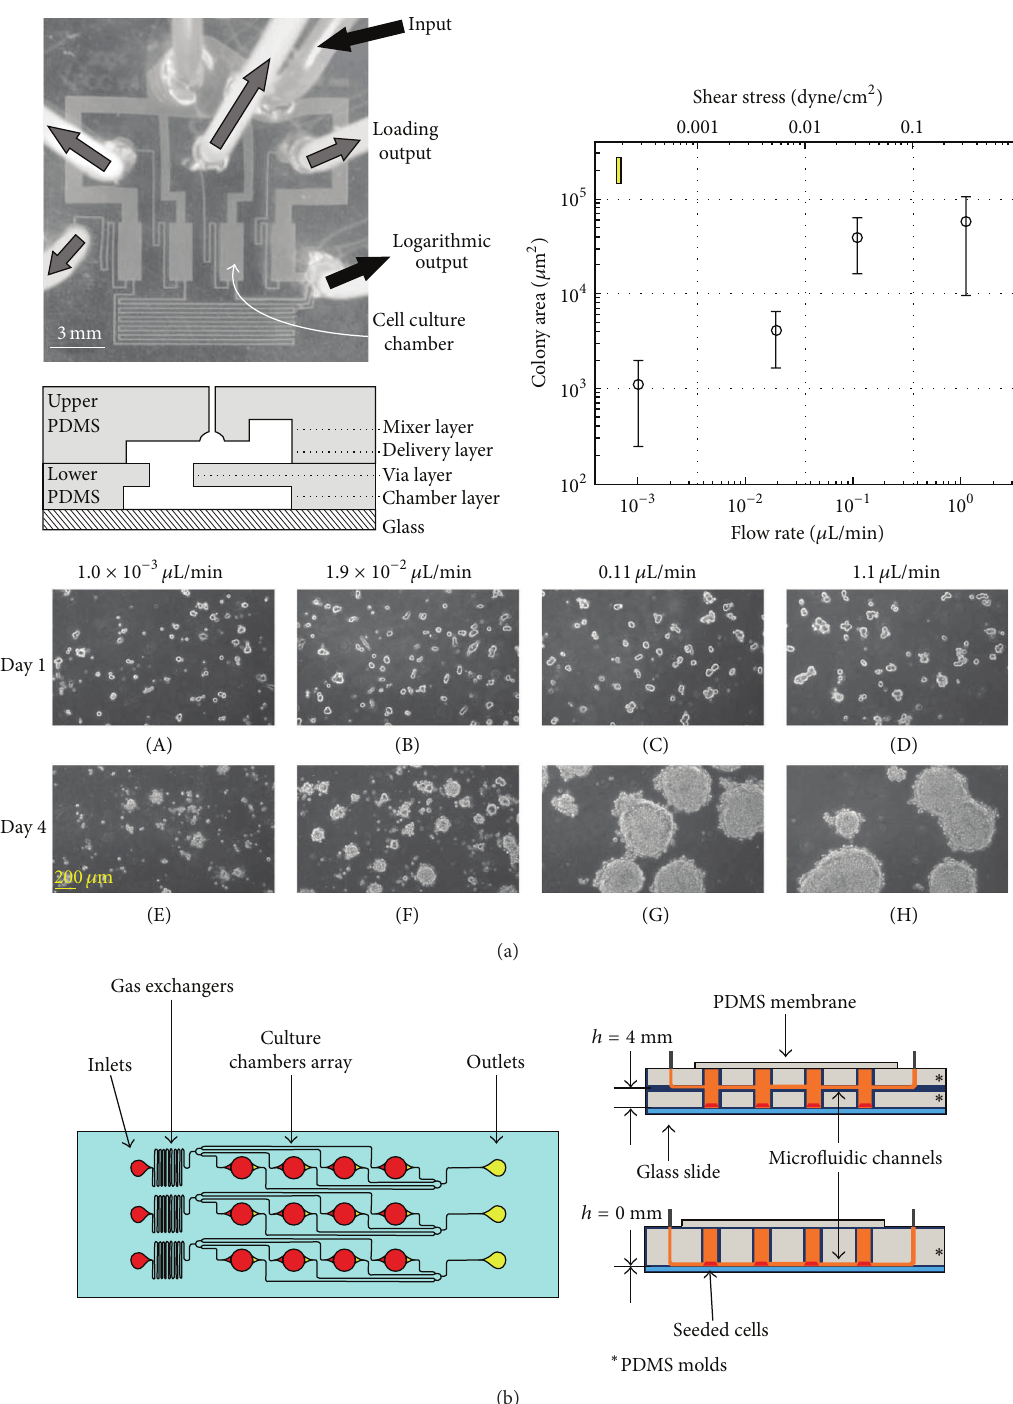
Figure 6: (a) Photograph and schematic illustrate the shear generation device. The microchannel consisted of mixer, delivery, via, and chamber layers. The flow was delivered through inlet; each chamber had different flow rate (shear stress) because of different flow resistance which was induced by the geometry. The data analysis showed that ESC colony development was proportional to the shear stress level. (b) Schematic illustration of another shear generation microfluidic system with gas exchangers. The two types of channels ( ℎ = 0 mm, ℎ = 4 mm) were used to create different shear stress levels. The result showed that the hESCs were more differentiated in high-shear (when ℎ = 0